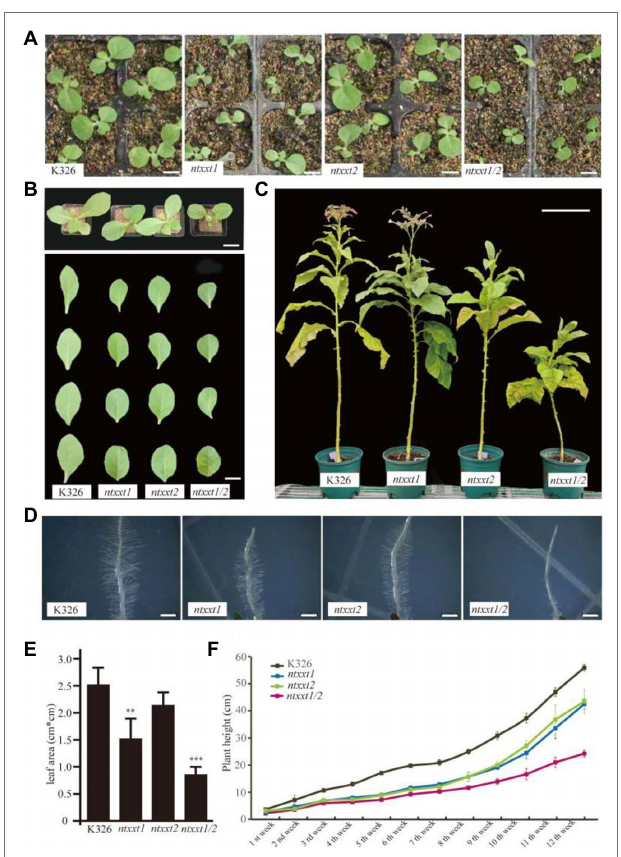
FIGURE 3 | The morphology phenotype of ntxx1/2 double mutants. (A) Two-week-old seedlings of K326, ntxxt1 , ntxxt2 , and ntxxt1/2 mutants. Bar = 1.5 cm. (B) The morphological phenotypes and leaf shape of K326, ntxxt1 , ntxxt2 , and ntxxt1/2 4-week-old seedlings. Bar = 3.5 cm. (C) The morphological phenotypes of K326, ntxxt1 , ntxxt2 , and ntxxt1/2 adult plants. Bar = 0.25 m. (D) Root hair phenotypes of K326, ntxxt1 , ntxxt2 , and ntxxt1/2 seedlings. Bar = 0.5 mm. (E) The statistical data leaf area of the 2-week-old K326, ntxxt1 , ntxxt2 , and ntxxt1/2 seedlings. ** Statistically significant differences from K326 using Student’s t- test ( p < 0.01), *** statistically significant differences from K326 using Student’s t -test ( p < 0.001). (F) The growth rates indicated by plant height of K326, ntxxt1 , ntxxt2 , and ntxxt1/2 mutants. These experiments were performed in triplicate. Error bars, mean ± SE.